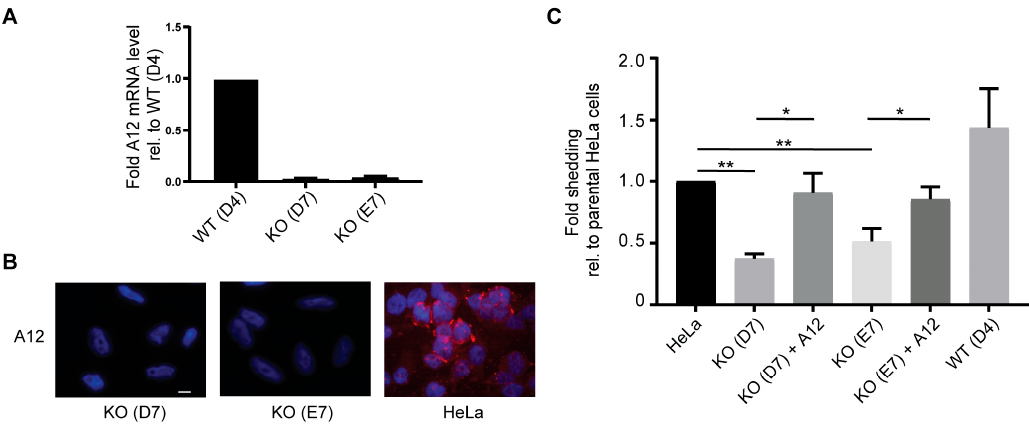
Figure 3. CRISPR/Cas9-mediated ADAM12 knockout reduces BSG reporter shedding. ( A ) qPCR analysis of A12 mRNA in CRISPR/Cas9 generated A12 knockout (clones D7 and E7) and non-edited wildtype (clone D4) HeLa cells. ( B ) Immunofluorescence staining of A12 in CRISPR/Cas9 generated A12 knockout HeLa clones (KO) D7 and E7, and parental HeLa cells. Nuclei were stained with 4 ′ ,6-diamidino-2-phenylindole ( DAPI) and scale bar = 12 µm. ( C ) Fold shedding of BSG-AP transfected parental HeLa cells, CRISPR/Cas9-generated A12 knockout (KO) HeLa clones D7 or E7 with or without A12 re-expressed, and the non-edited wildtype (WT) clone D4, as indicated. Values represent means ± SEM from three independent experiments. * p < 0.05, ** p < 0.005, ANOVA.